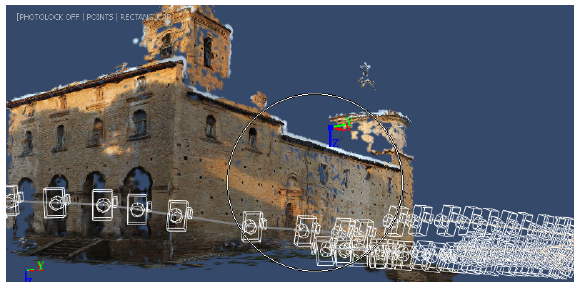
Figure 12. Santa Maria in Piano, Loreto Aprutino (Pescara), Automatic Reconstruction, Front View